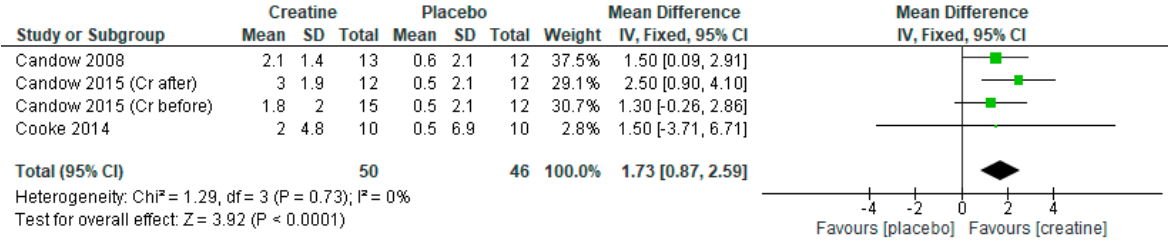
(Figure 8: standard mean difference = 0.44 [95% CI: 0.06, 0.81] p = 0.02). Of note, Cooke et Figure 5. Forest plot of higher-dose creatine studies (>5 g/day) on leg press strength with exclusion of creatine-loading studies.